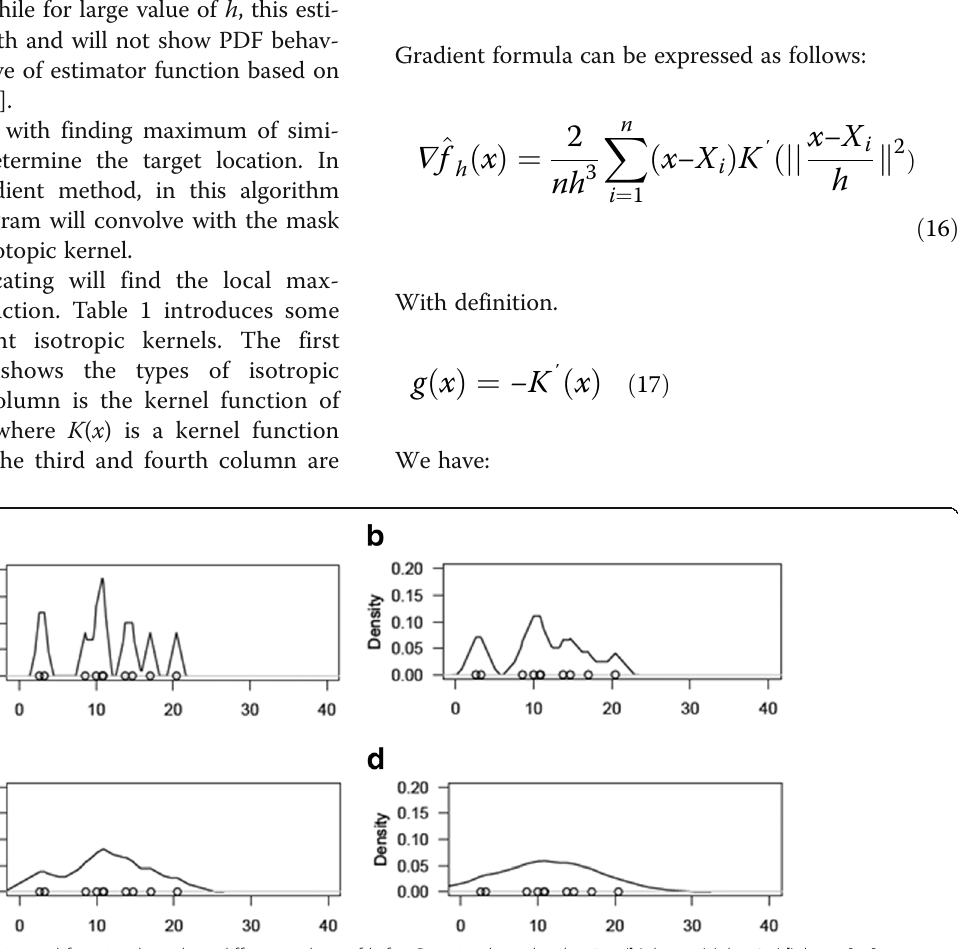
Fig. 5 Comparison of the estimated function based on different values of h for Guassian kernel. a h = 0.5, ( b ) h = 1, ( c ) h = 2, ( d ) h = 4